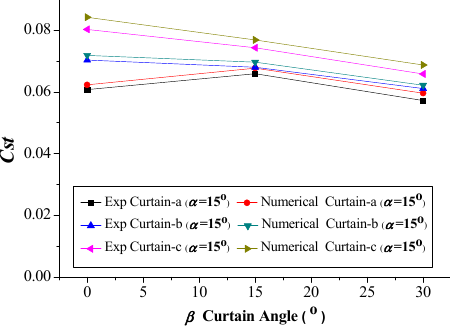
Figure 17. Static torque coefficients for different parameters ( θ = 165°).